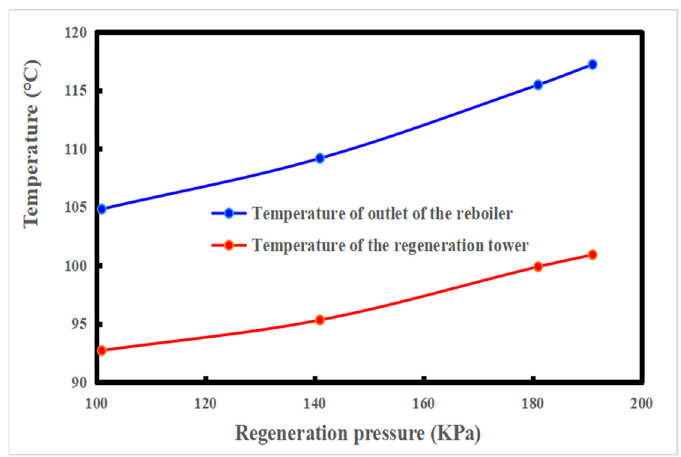
Figure 6. Effect of the regeneration pressure on the temperature in the regeneration tower and the outlet of the reboiler. The steam consumption is 60 kg/h, liquid–gas ratio is 1.82 L/m 3 , interstage cooling temperature is 40 °C, and rich liquid fractional flow ratio is 0.